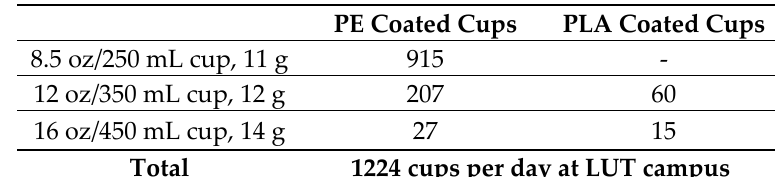
Table 1. Paper cup sizes, amounts, and types used at Lappeenranta University of Technology (LUT)